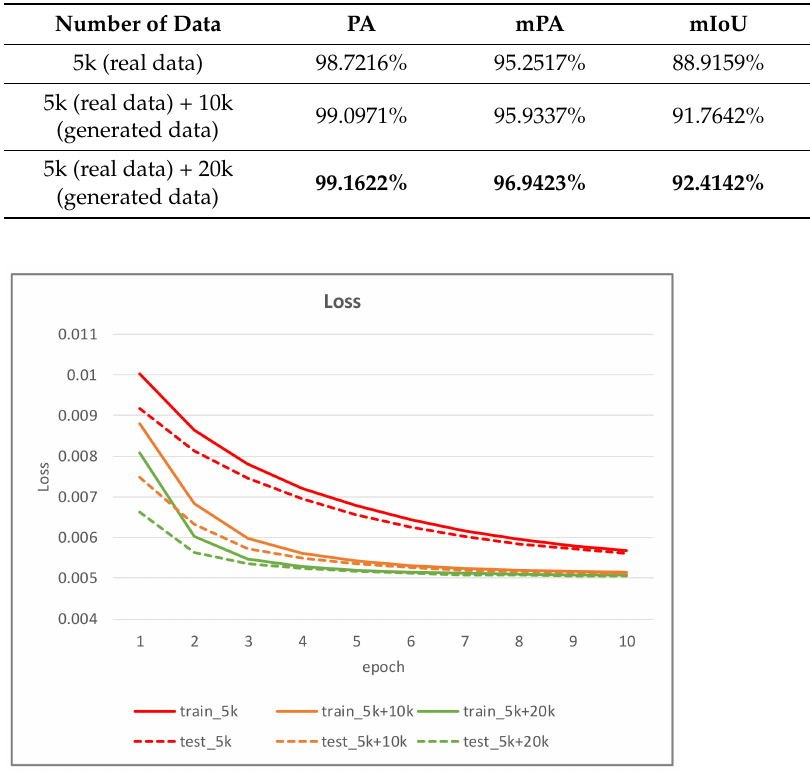
Figure 8. The loss curve of the proposed method on training data and testing data.